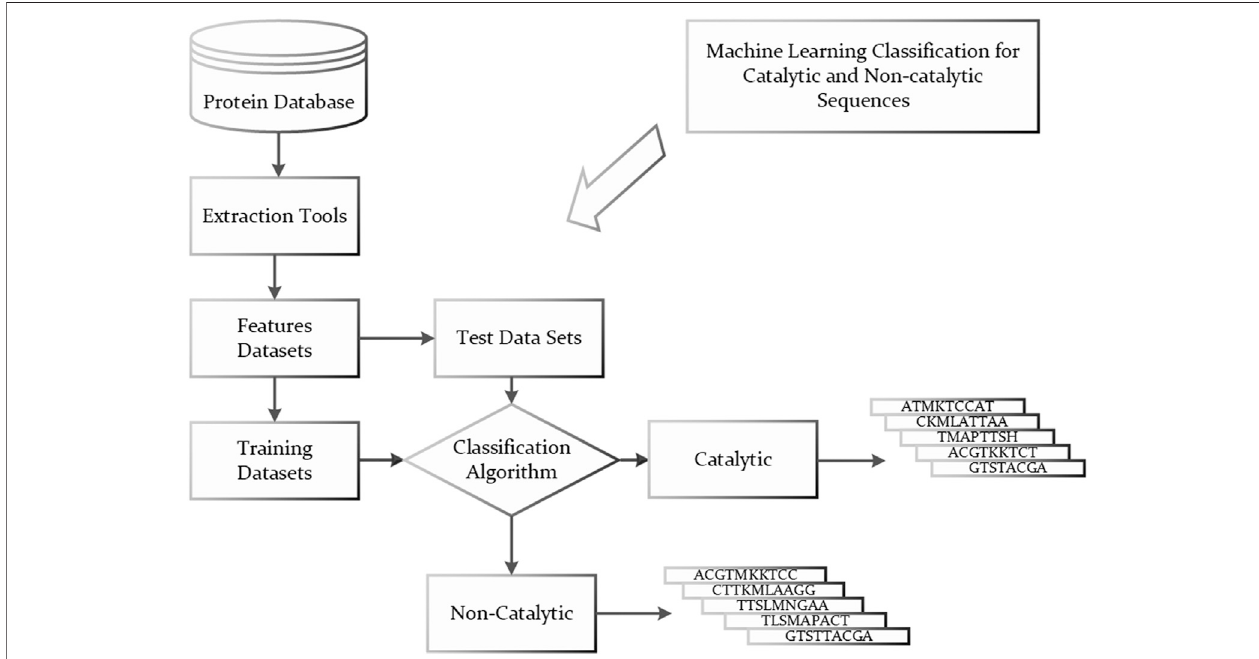
FIGURE 1 | Classi fi cation of catalytic and non-catalytic protein